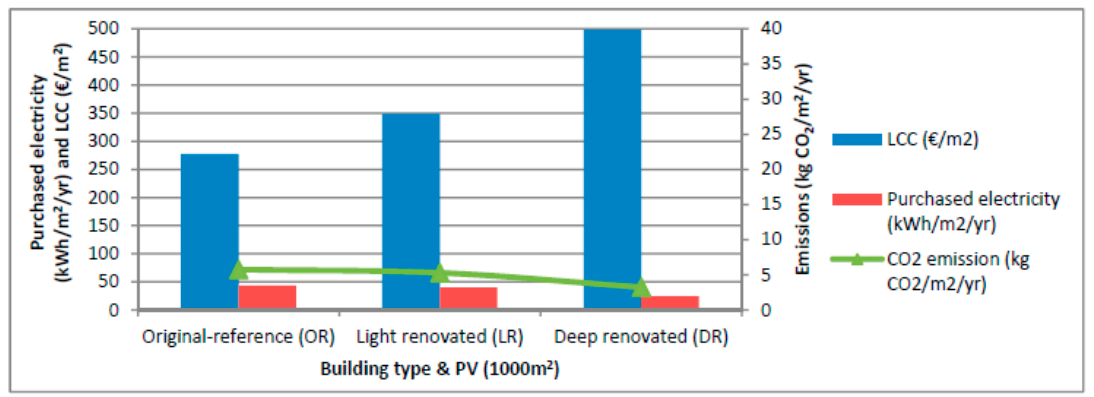
Figure 13. The annual purchased electricity, LCC, and CO 2 emissions from the centralized community-level PV, HP, and seasonal storage-based energy system integrated with old residential buildings (Case 3, PV + A2W + GSHP +